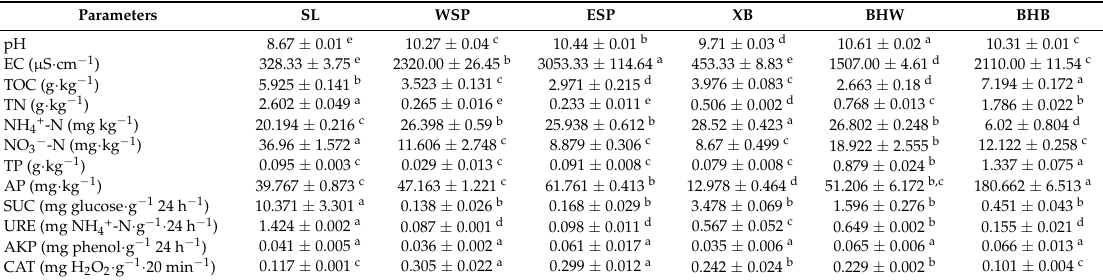
Table 1. Original characteristics of GIWs’ sediment in temperature simulation experiments under different flooding periods in the Hulunbuir